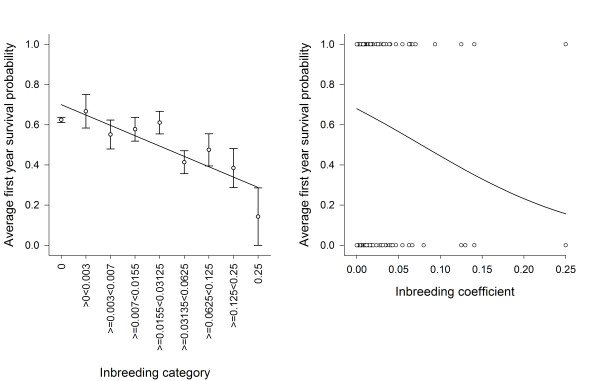
The association between an offspring's inbreeding coefficient and its probability of first year survival. The left-hand plot shows averages of raw data (so not correcting for terms in the minimal model) for offspring with inbreeding coefficients binned as detailed on the x-axis, with bars representing standard errors. The right hand plot shows model predictions from a model including birth weights (solid line) and actual data (open circles; please note that a given circle may represent multiple data points, e.g. for F = 0.25, there was 1 survivor and 6 non-survivors). Offspring were less likely to survive their first year with increasing inbreeding coefficient.